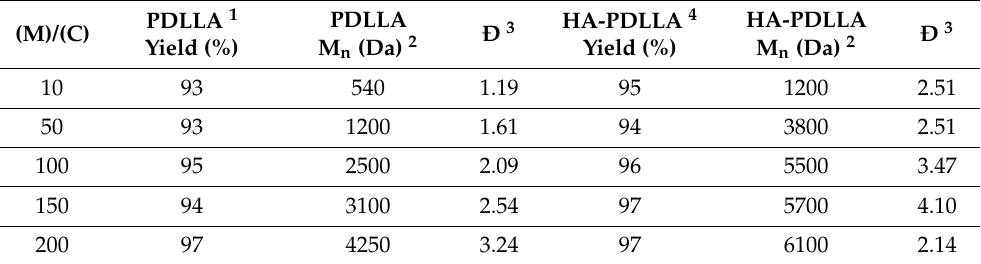
Table 1. Polymerization of D , L -lactide in toluene at 111 ◦ C for 3 h with Cyclooctanol/Sn(Oct) 2 or Hydroxyapatite/Sn(Oct) 2 and different (Monomer)/(Catalyst) ratios.